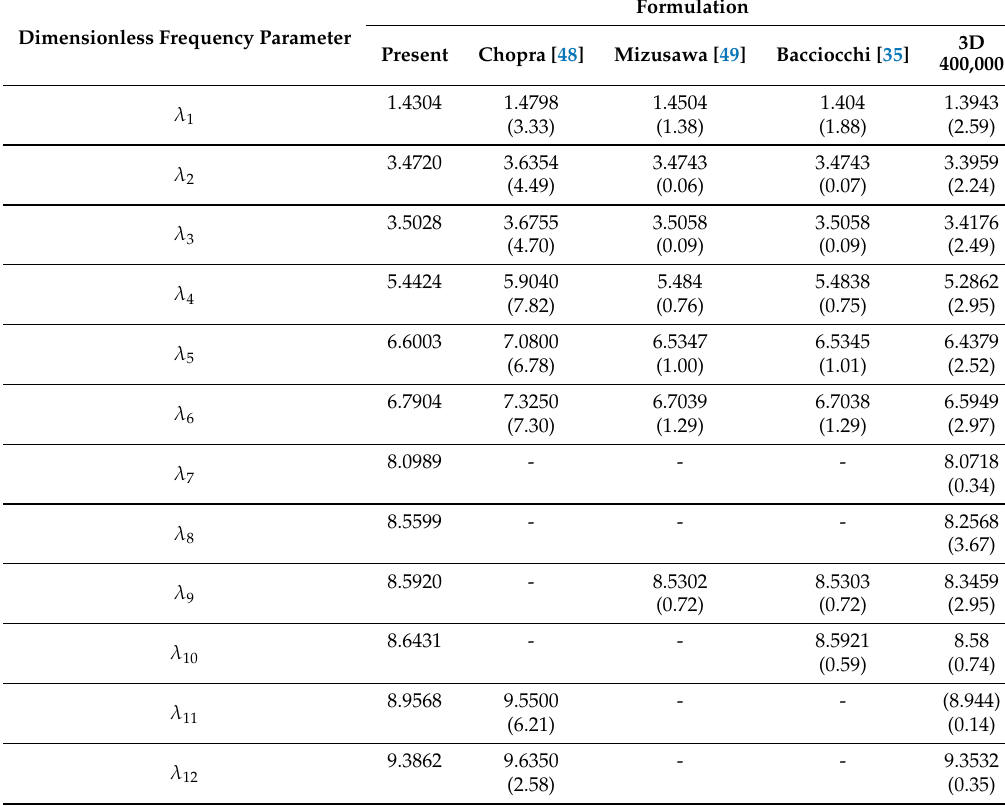
Table 9. Comparison of results for a square plate of ratio b / h 0 = 20 and SSSS boundary